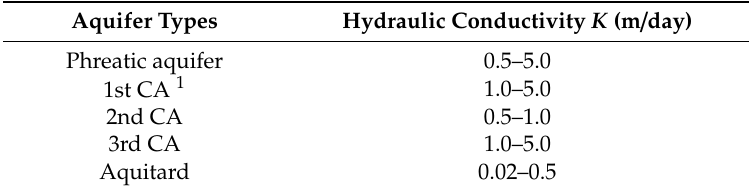
Table 3. Initial values of hydraulic conductivity for different aquifers.